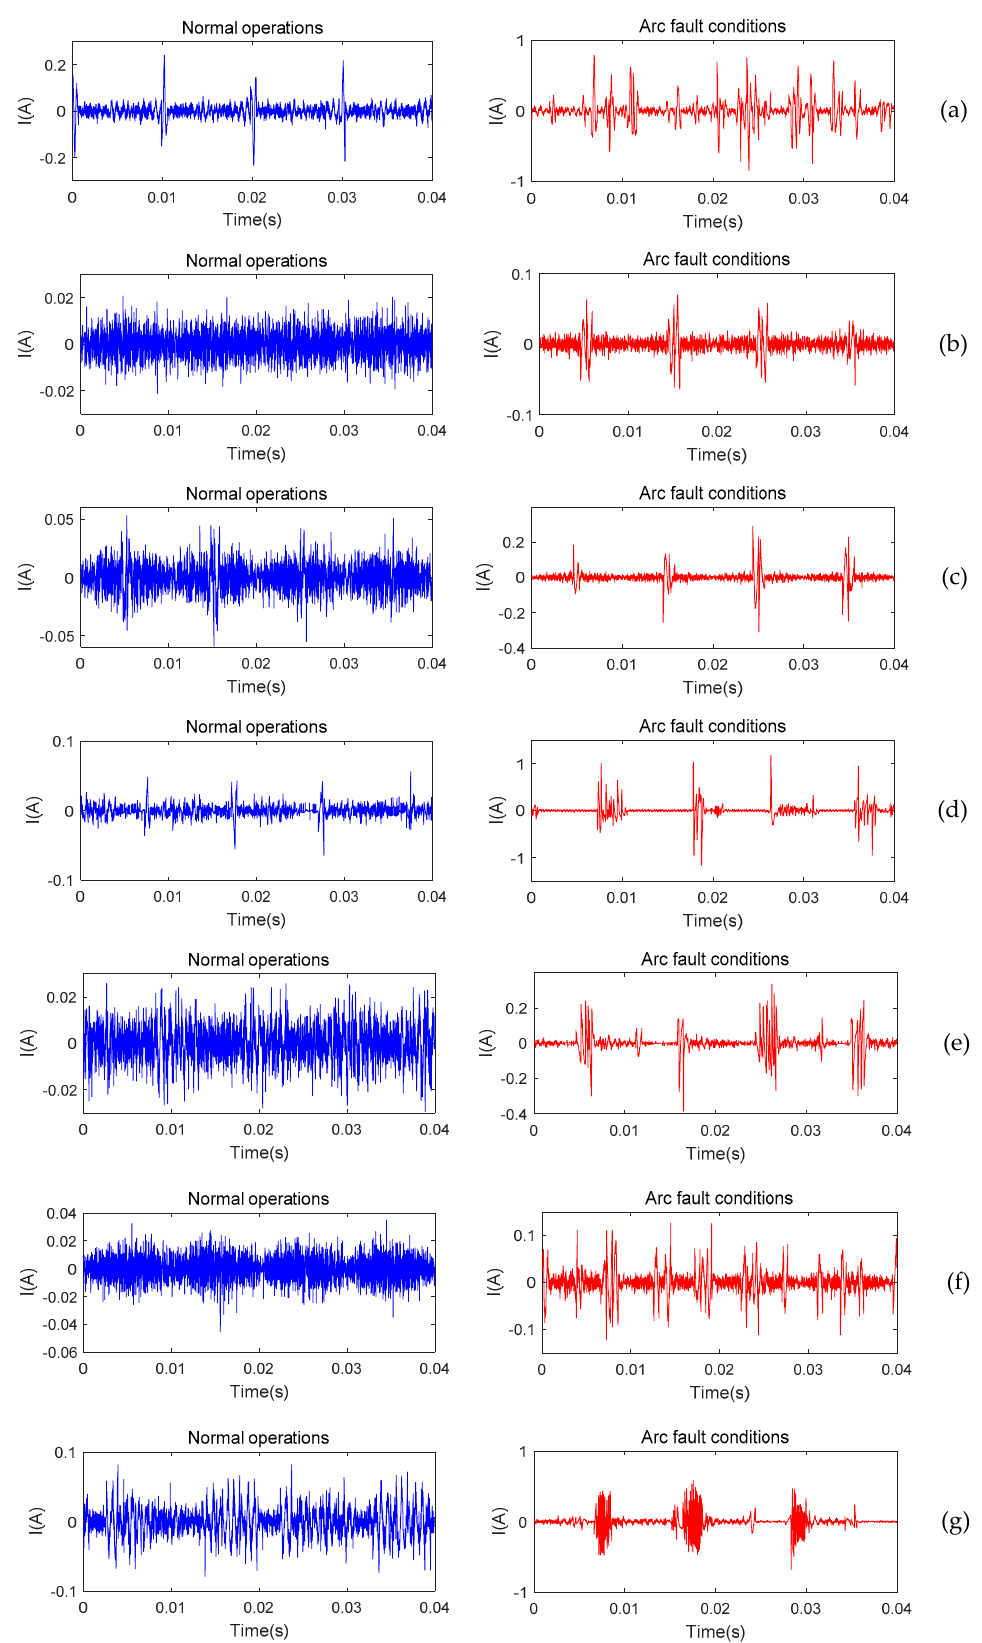
Figure 6. The waveform of different load types during normal operations and serial arc fault conditions after filtering. ( a ) Induction cooker. ( b ) Incandescent lamp. ( c ) Hairdryer. ( d ) Notebook computer. ( e ) Electric drill. ( f ) Electric oven. ( g ) Vacuum cleaner.